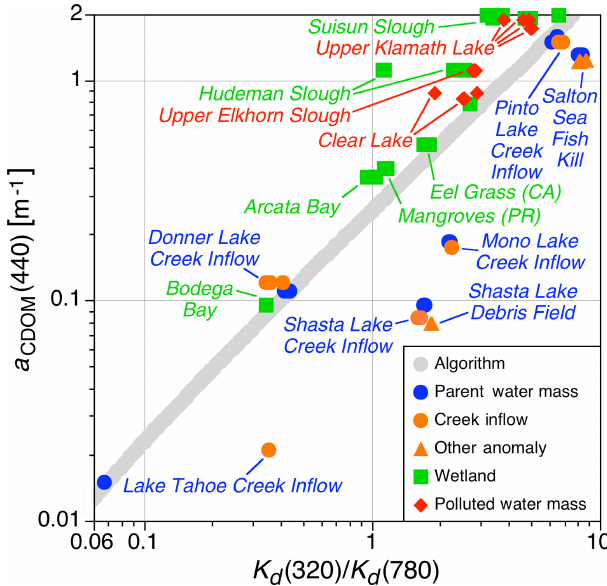
Figure 7. The new data obtained in a wetland or polluted water mass plus comparisons between a parent water mass and a creek inflow or another source of water